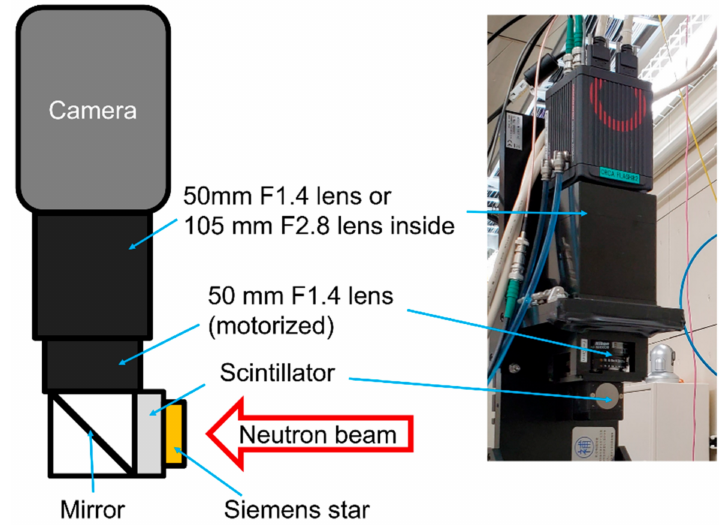
Figure 1. Schematic and picture of the experimental